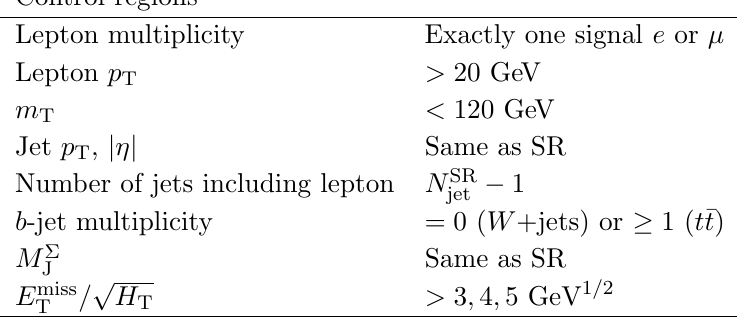
Table 2. De(cid:12)nition of the leptonic control regions, used to normalise the t (cid:22) t and W +jets back- grounds. In the control regions, the lepton is recast as a jet if it satis(cid:12)es the same kinematic criteria as the jets. Such leptons contribute to the E miss